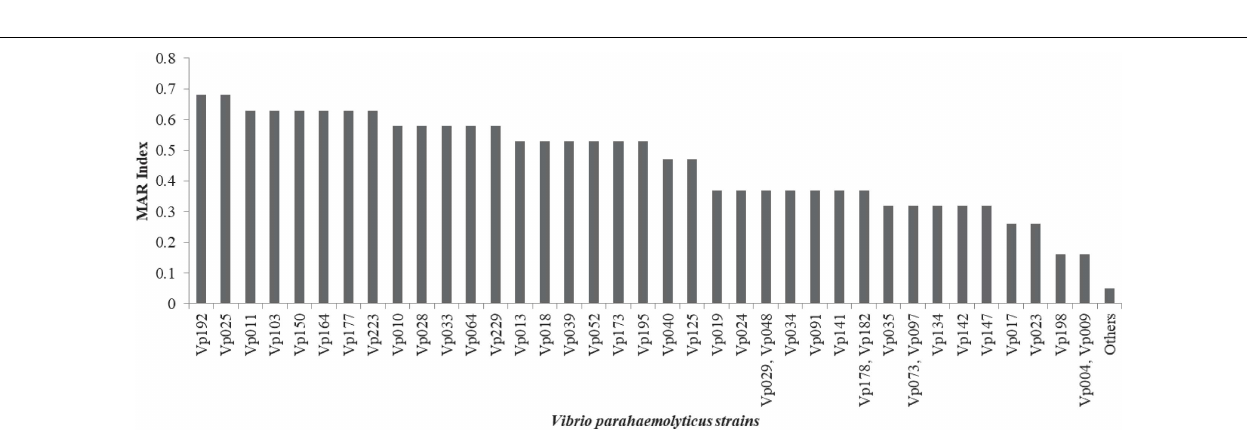
FIGURE 5 | The MDR profile of V. parahaemolyticus from African salads.